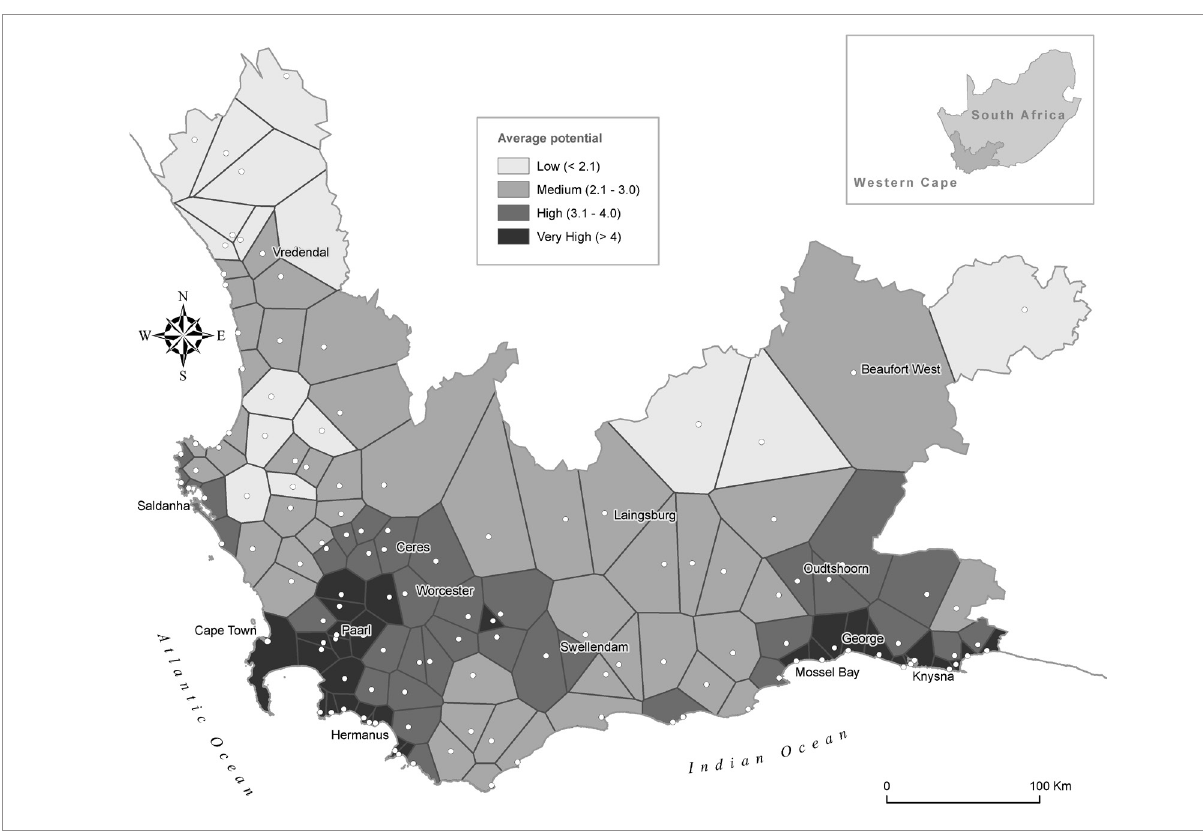
Figure 3: Potential of all tourism products per town in the Western Cape Province.